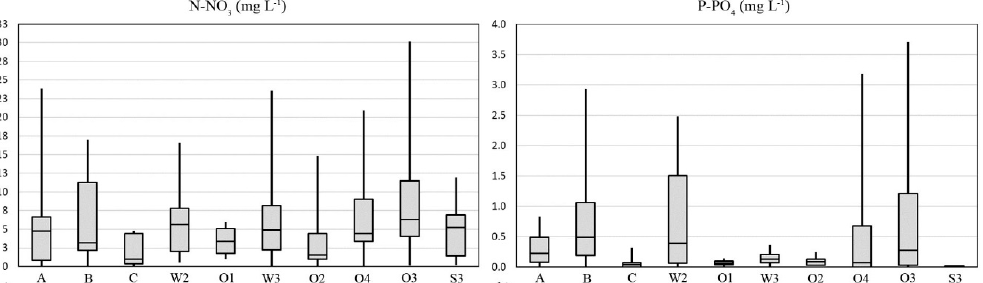
Figure 6. Box plots of N-NO 3 ( a ) and P-PO 4 ( b ) measured in ten river sections along the Canale d’Aiedda river network. The horizontal line within each box plot indicates the median; lower and upper boundaries of each box indicate the 25th and 75th percentiles, respectively. The lower and the upper whiskers indicate the minimum and the 95th percentile of the values for each box, respectively.